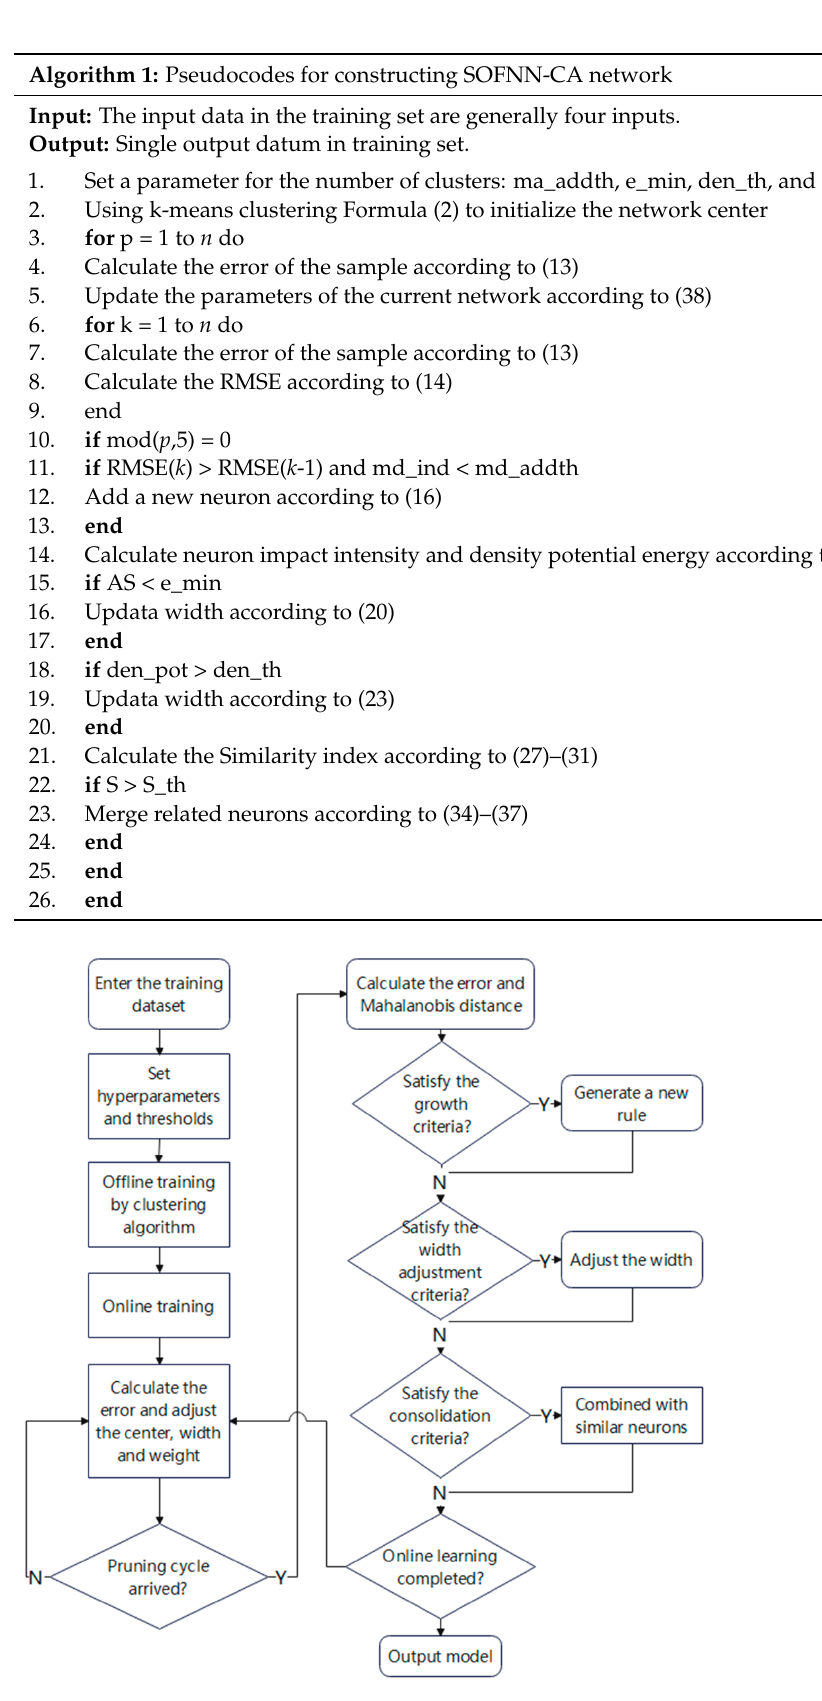
Figure 6. The flowchart of SOFNN-CA. Algorithm 1 Pseudocodes for constructing SOFNN-CA network